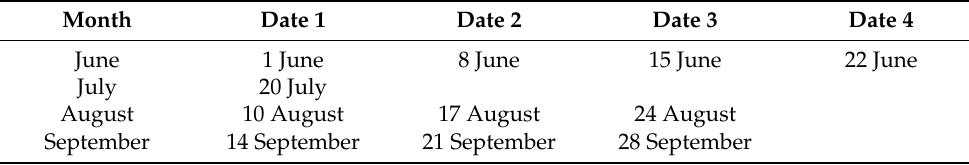
Table 2. PALSAR-2 observation dates (2019) used for computing the coefficient of